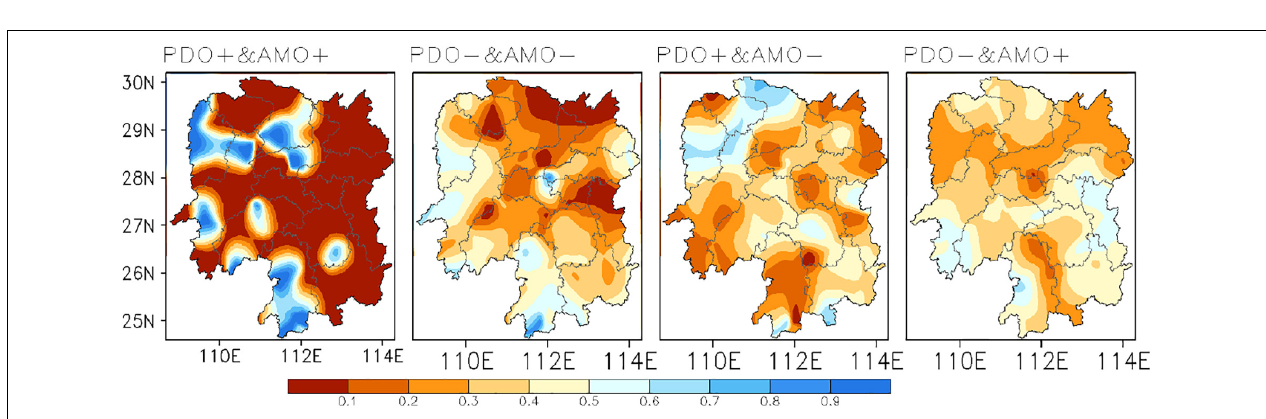
FIGURE 6 | The same as Figure 4 , but for the next years of La Niña events and the precipitation series is processed by the low-pass filtering.